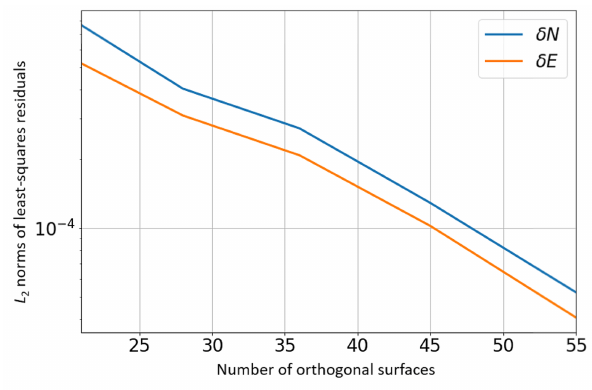
Figure 9. Residual L 2 norms.